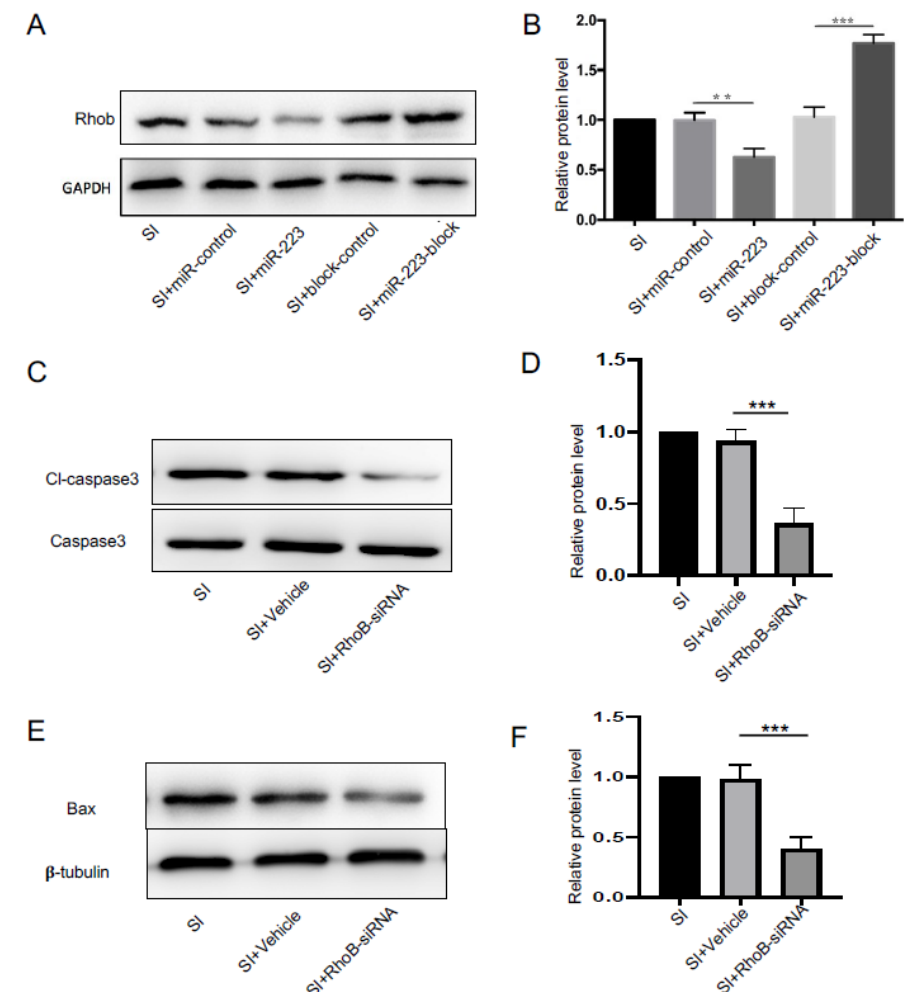
Figure 6. MiR-223 inhibited rhoB expression, and knockdown of RhoB decreased caspase-3 activation. ( A ) Protein expression of RohB in Western blots. ( B ) Bar graphs showing quantification of RohB. ( C ) RohB-siRNA limited the expression of cl-caspase-3 in Western blots. ( D ) Bar graphs showing quantification of cl-caspase-3. ( E ) RohB-siRNA limited the expression of BAX in Western blots. ( F ) Bar graphs showing quantification of BAX. n = 6 per group; data are presented as the mean ± SD; ** p < 0.01, *** p < 0.001, miR-223 versus miR-control group, miR-223-block versus block-control group, siRNA versus vehicle group. miR-223: microRNA-223; cl-caspase-3: cleaved-caspase-3.